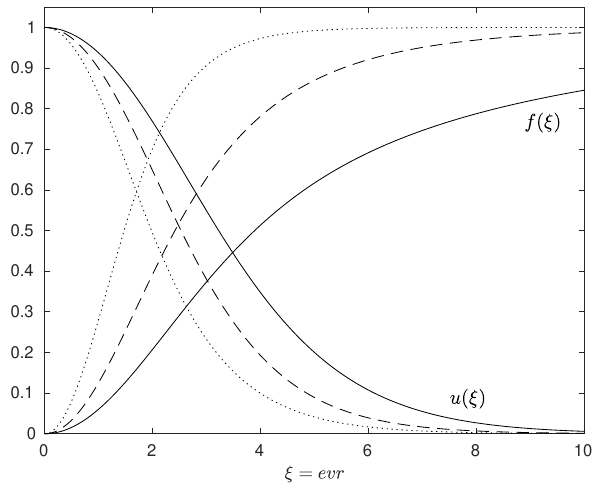
Figure 1 . The monopole pro(cid:12)le functions u ( (cid:24) ) and f ( (cid:24) ) for (cid:21)=e 2 = 0 (solid curves), (cid:21)=e 2 = 0 : 1 (dashed curves) and (cid:21)=e 2 = 1 (dotted